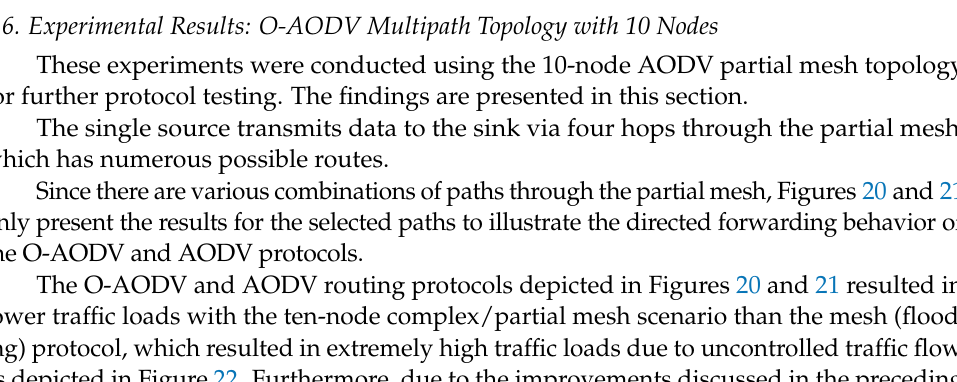
Figure 19. PDR: O-AODV, AODV, and mesh (flooding)